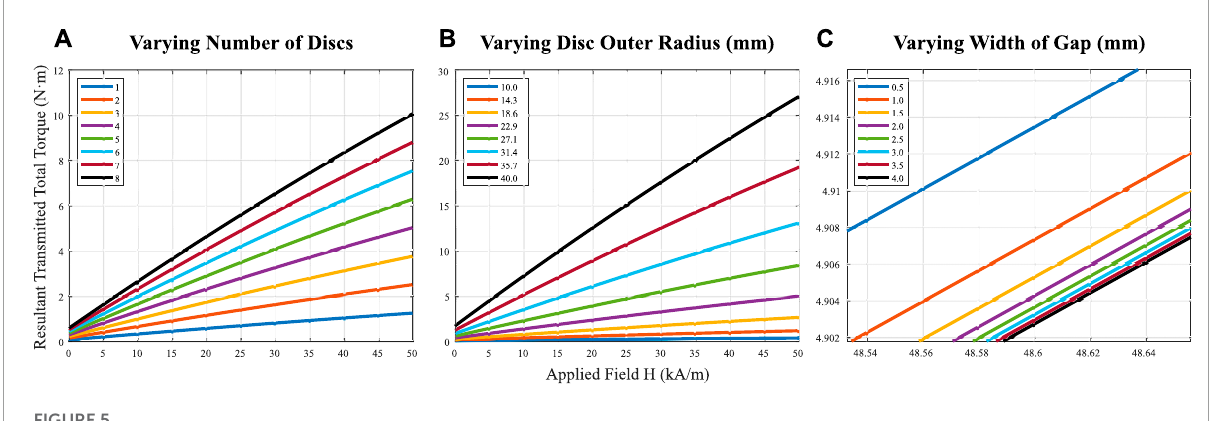
FIGURE 5 Three simulations of the effect of varying physical parameters of the MEC on transmitted torques. Transmitted torque increases with (A) adding additional fins, and (B) larger radii of the fins. Transmitted torque decreases with (C) larger gap sizes, but by a relatively small amount (0.12% decrease at 48 kA/m from 0.5 mm to 1.0 mm gap